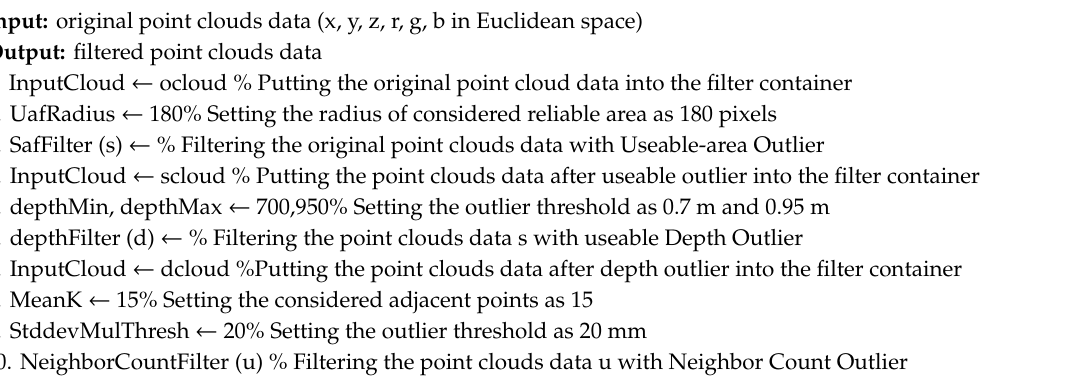
Algorithm 1. Filtering with usable area, depth cut-o ff and neighbor count method of original point